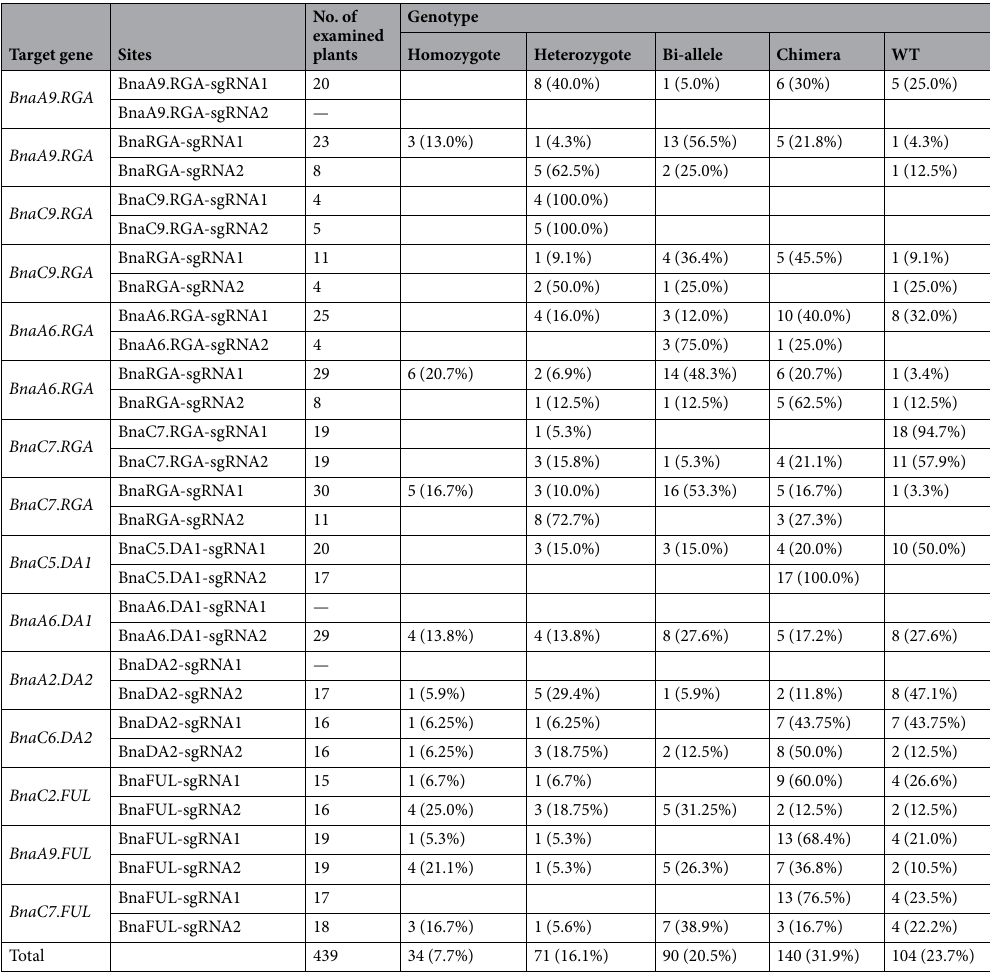
Table 3. Genotypes of T0 transgenic plants. ‘—’: the sequencing results were not well decoded by DSDecode.